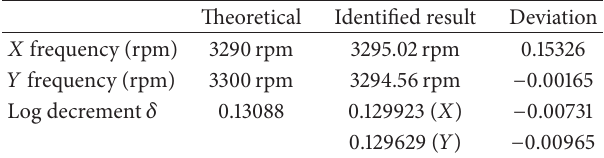
Table 1: Comparison between theoretical and identified result.